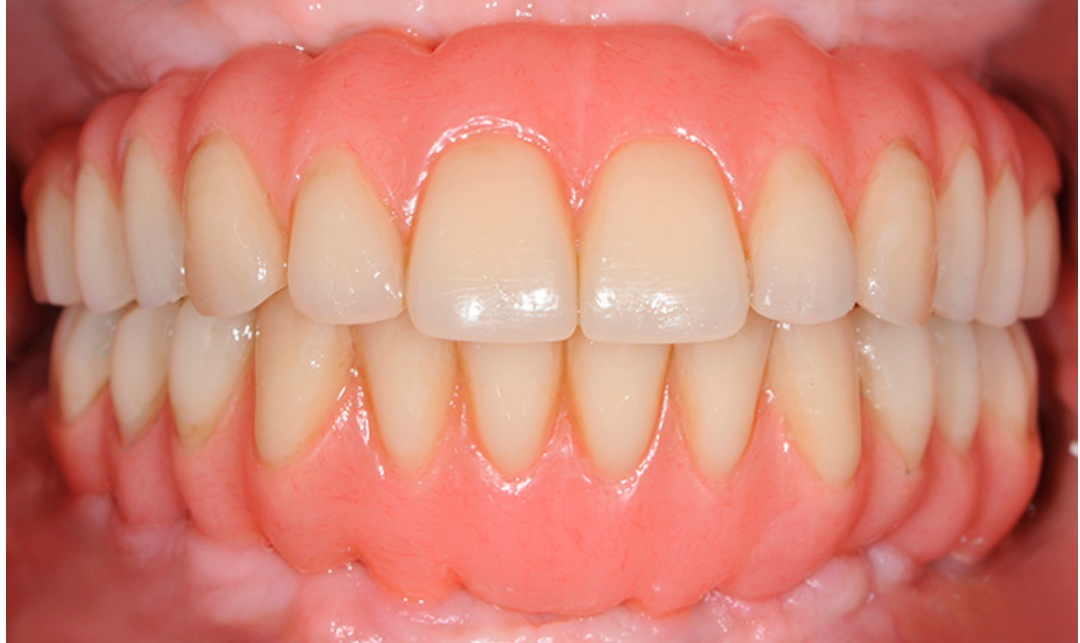
Figure 4. Definitive prosthetic rehabilitation.